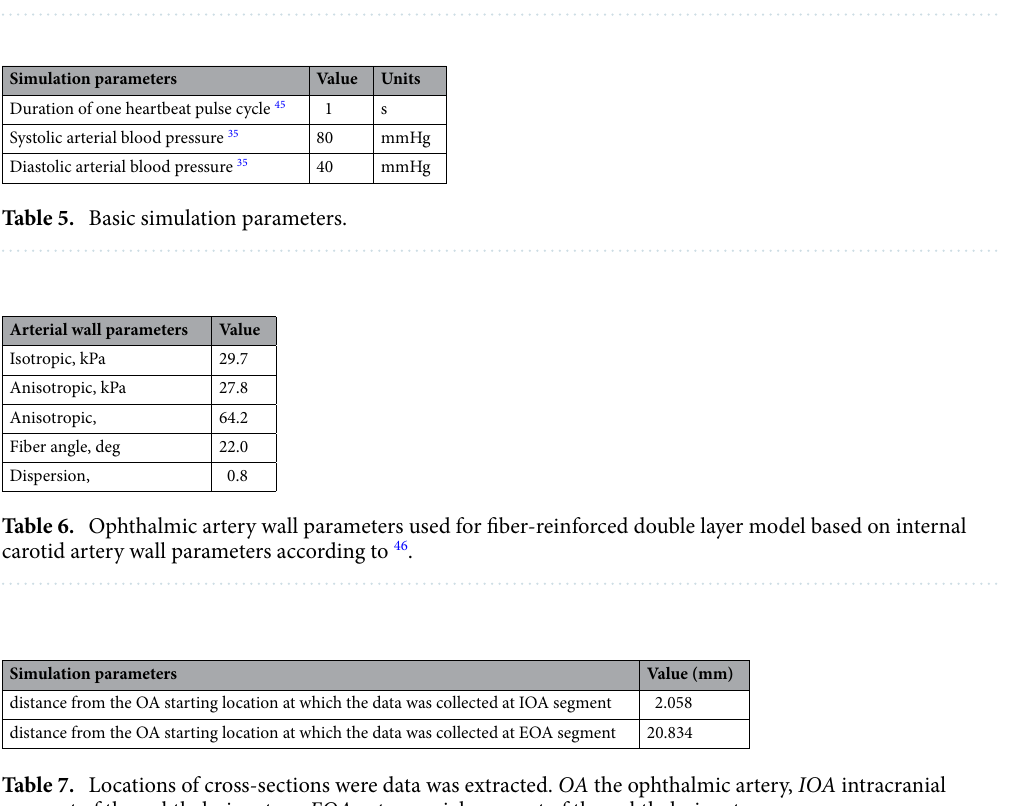
Figure 7. Typical maximum blood flow velocity waveform in ophthalmic artery that was implemented in the numerical